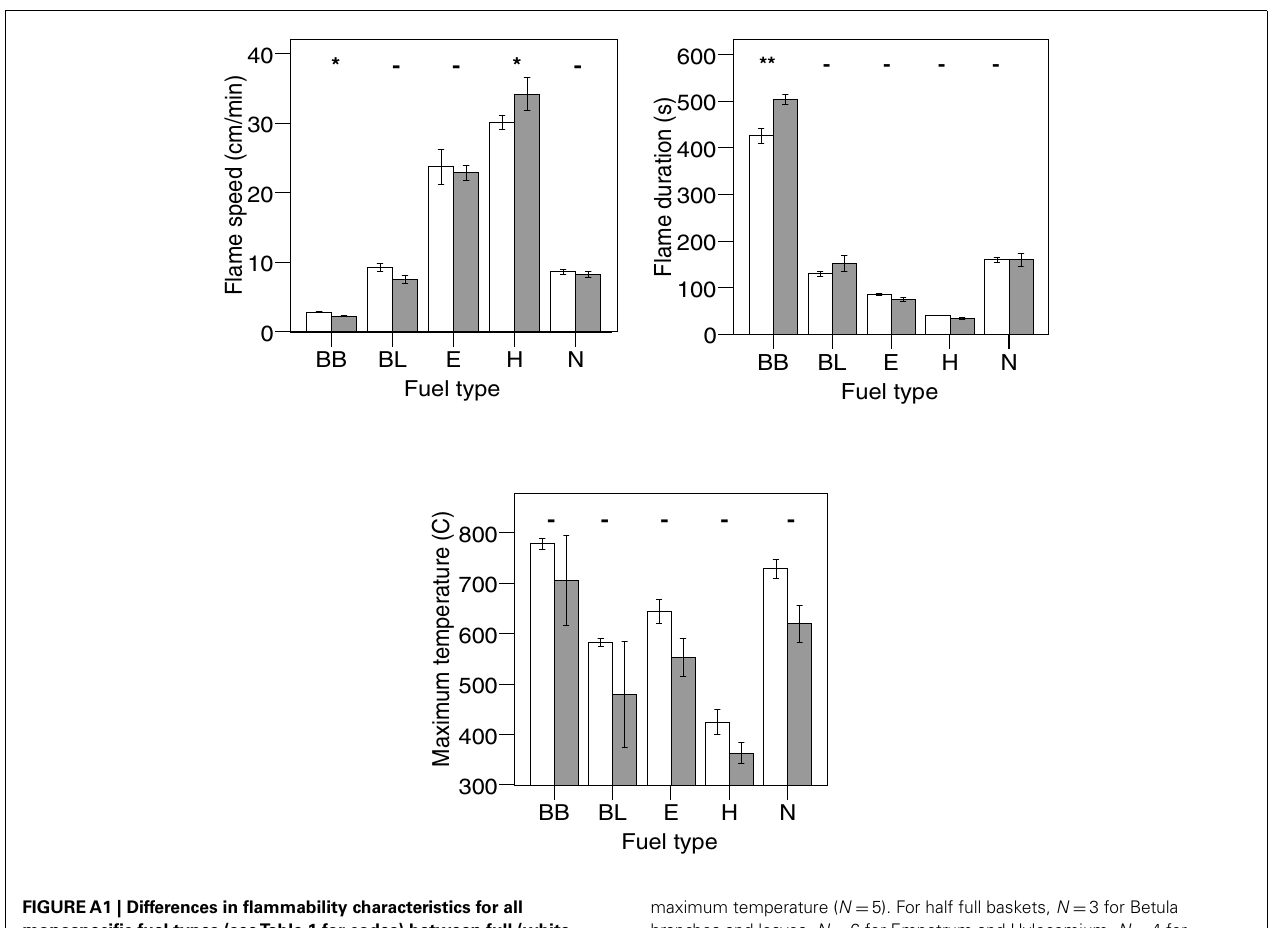
FIGUREA1 | Differences in flammability characteristics for all monospecific fuel types (seeTable 1 for codes) between full (white bars) and half full baskets (grey bars). Means and SE are indicated, N = 6 for each material and flammability variable, except for Betula leaves for the variable flame duration ( N = 5) and Nephroma for average